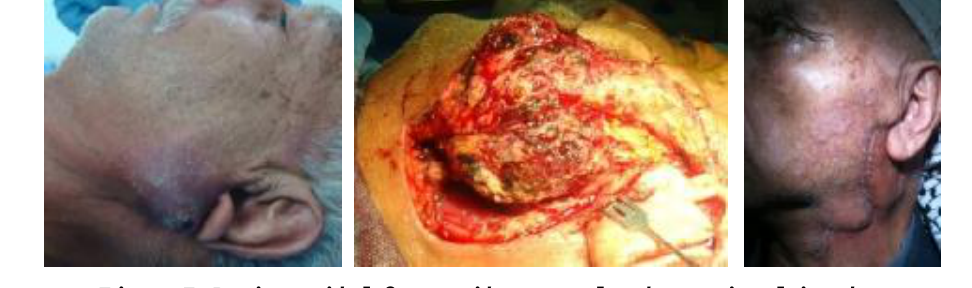
Figure 7: Patient with left parotid encapsulated mass involving the overlying skin resected and reconstructed with local advancement flap.